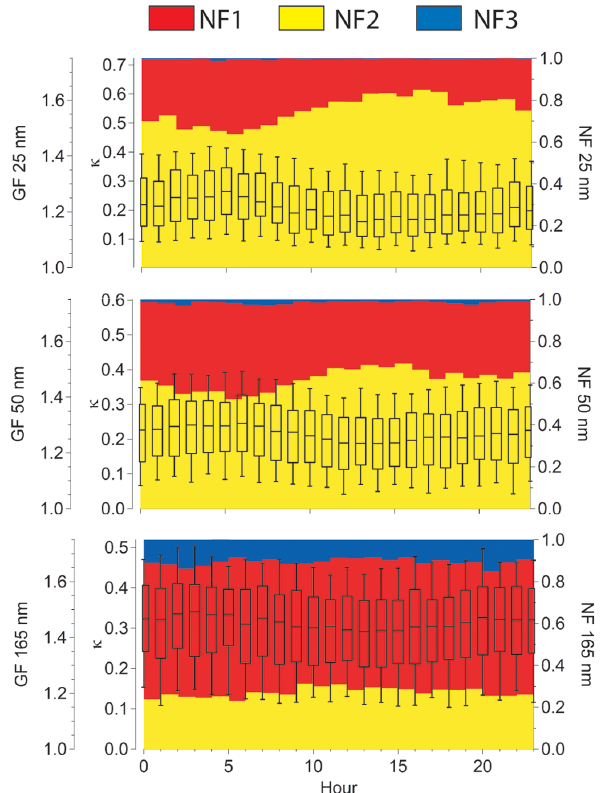
Figure 6. Diurnal variation of hygroscopic growth factor (GF), kappa value ( κ) and number fractions (NF) measured at RH90 for particles in the nucleation mode (top panel), Aitken mode (middle panel) and accumulation mode (bottom panel). The figure shows the median GF value, with the bottom and top sides of the box giving the 25th and 75th percentiles, and the extremities the 10th and 90th percentiles. The coloured bars illustrate the NF of particles found in each hygroscopic mode.